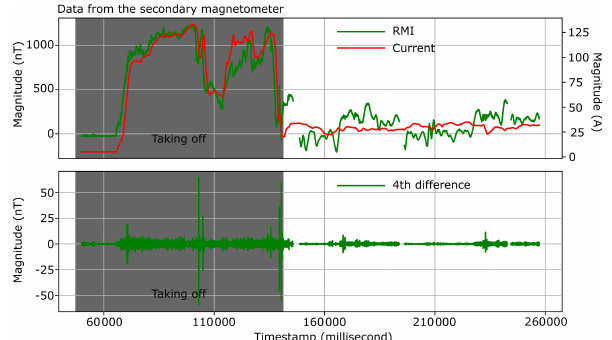
Figure 13. Data excerpt of RMI profile recorded by the secondary magnetometer and its fourth difference, together with the profile of output current from the battery with d = 20cm and L = 30cm. The IGRF (50563nT) has been removed.